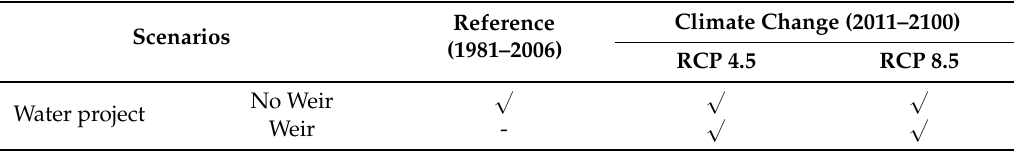
Table 5. Five simulation conditions to run the model.